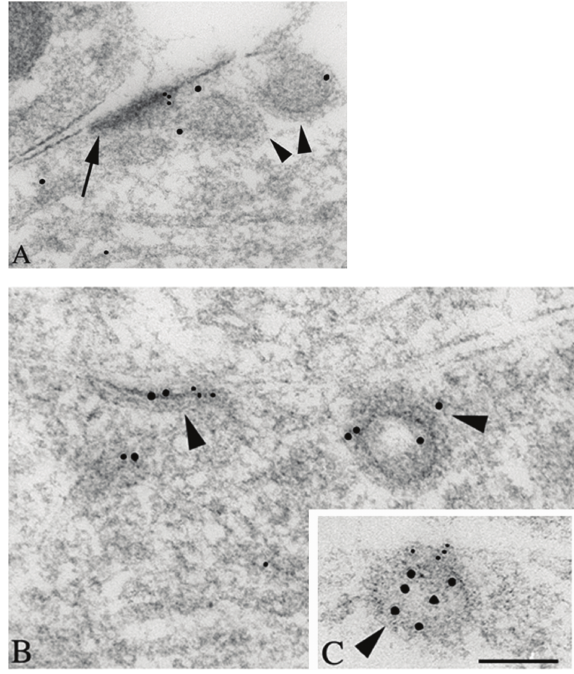
Figure 2: Double immunogold labeling of clathrin-coated pits/ vesicles (CCP/V; arrowheads) associated with a “bare density” (A; arrow) and extrasynaptic membrane regions (B, C) in the CA1 stratum radiatum of the P2 hippocampus, labeled for NR1 (A, B; 5nm gold) or NR2A/B (C; 5 nm gold), and clathrin (10 nm gold). The “bare density” (labeled for NR1) on the dendrite in A actually has a fairly close association with an adjacent process. In the dendrite in B, NR1 and clathrin label an early, flat CCP/V adjacent to a CCP/V that is pinching o ff . In C, NR2A/B labeling on the cell surface is continuous with a clathrin-labeled CCP/V. Scale bar is 100nm. Reprinted from part of Figure 3 from Petralia et al.